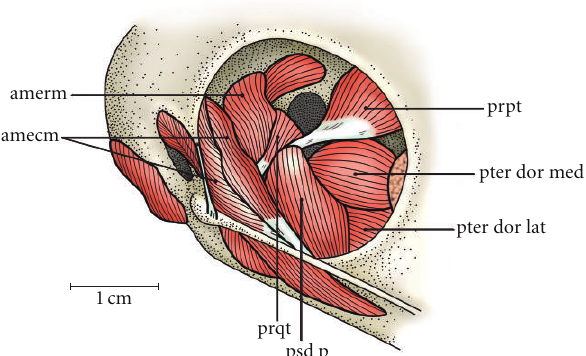
Figure 8: An oblique deep view of the jaw muscles of Picus miniaceus. amecm: adductor mandibulae externus caudalis medialis; amerm: adductor mandibulae externus rostralis medialis; prpt: protractor pterygoidei; prqt: protractor quadrati; psd p: pseudotemporalis profundus; pter dor lat: pterygoideus dorsalis lateralis; pter dor med: pterygoideus dorsalis